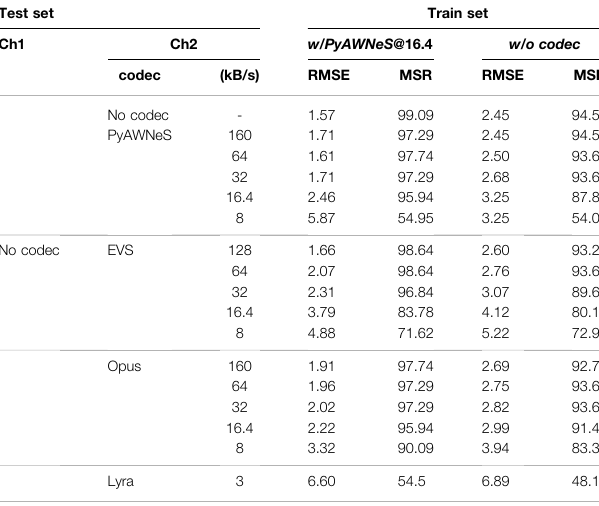
TABLE 3 | Performance in terms of RMSE ( ◦ ) and MSR% in seen and unseen codecs conditions using the model serving as baseline trained without compression ( w / o codec ) and models trained with PyAWNeS at 16.4(w/PyAWNeS@16.4). Test